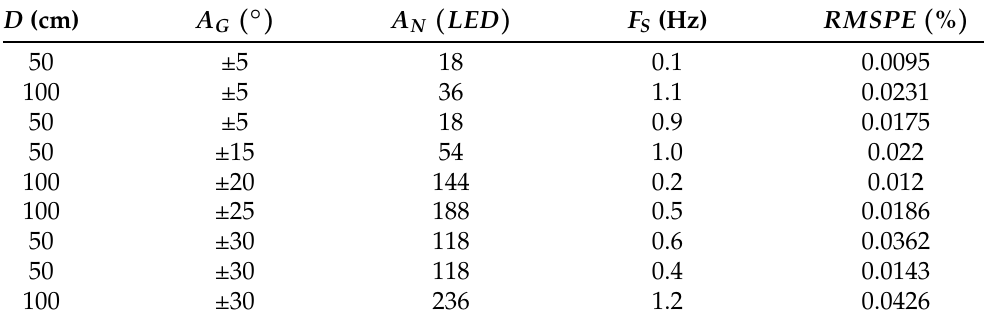
Table 4. RMSPE results for SPSS signals with certain patient-stimulus distance ( D ), number of LEDS ( A N ), stimulus amplitude ( A G ) and frequency ( F S